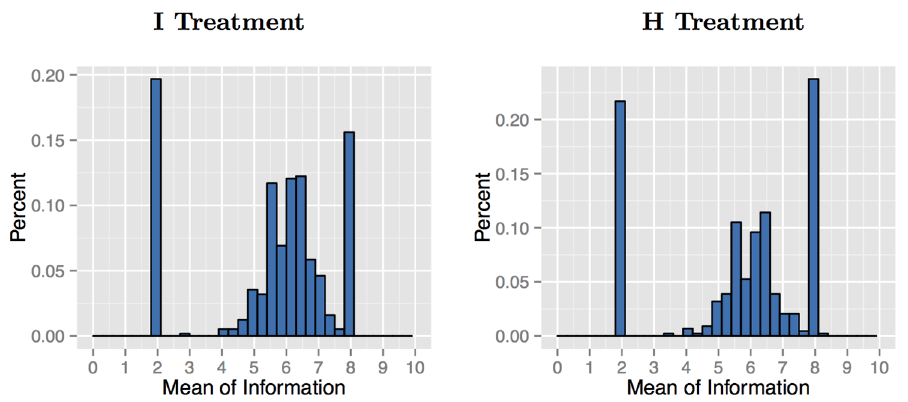
doi:10.1371/journal.pone.0147043.g002